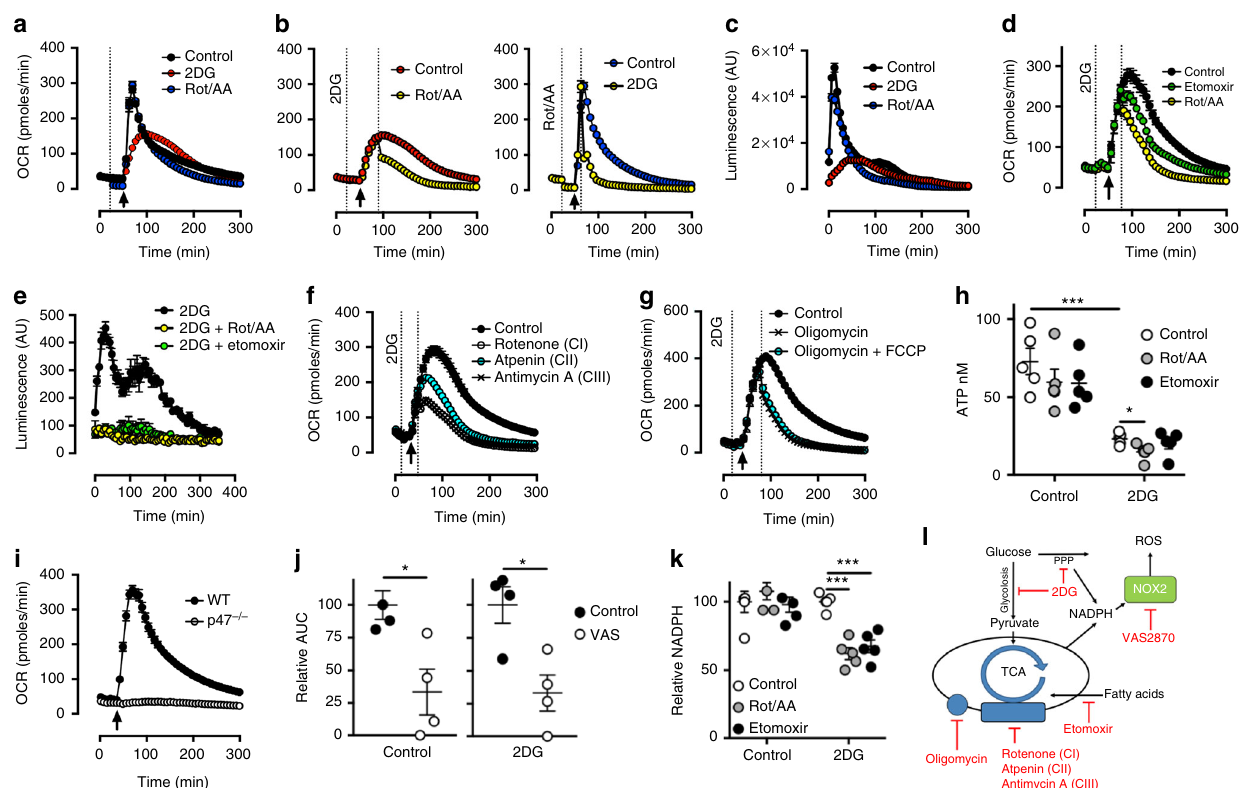
Fig. 2 Neutrophil mitochondria facilitate free radical production. a C57Bl/6J bone marrow neutrophil respiratory burst was measured by oxygen consumption rate (OCR) in response to phorbol 12-myristate 13-acetate (PMA) at the arrow following the addition of indicated compounds at the dotted line. b Following stimulation as described in panel ( a ), neutrophils received a second stimulation of indicated compounds at the second line. Control from panel ( a ). c H 2 O 2 production from bone marrow neutrophils in response to PMA 20 min after the addition of the indicated individual compounds. d OCR in response to the indicated compounds at the second line following the addition of PMA (arrow) and 2DG ( fi rst line). e H 2 O 2 production in response to PMA 20 min after addition of 2DG alone or in combination with the indicated compounds. f OCR values in response to Inhibitors to electron transport chain complexes (CI-III) added at the second line following stimulation with PMA (arrow) and 2DG ( fi rst line). g OCR in response to the complex V inhibitor Oligomycin and Carbonyl cyanide- 4 -(tri fl uoromethoxy)phenylhydrazone (FCCP) were added at the second line, following stimulation with PMA (arrow) and 2DG ( fi rst line). h ATP content of PMA-stimulated bone marrow neutrophils following inhibition with indicated compounds in the presence or absence of 2DG. Data ( n = 5 per group) were analysed by two-way ANOVA with Tukey ’ s multiple comparisons indicated. i OCR in p47 − / − neutrophils in response to PMA (arrow). j Relative total oxygen consumption in response to PMA during NADPH oxidase inhibition by VAS-2870 in the presence or absence of 2DG. Data were analysed by Student's t -test. Control n = 3 pooled from three independent experiments, 2DG n = 4 pooled from two independent experiments. k Relative NADPH levels in PMA-stimulated neutrophils in the presence or absence of 2DG following treatment with indicated compounds. Data ( n = 5) representative of two independent experiments and were analysed by two-way ANOVA with Tukey ’ s multiple comparisons indicated. l Schematic displaying our metabolic model of ROS support, with indicated inhibitors. Concentrations were: Rotenone (Rot, 100 nM), Atpenin (1 µ M), Antimycin A (AA, 1 µ M), 2-DG (100 mM), PMA (1 µ g/ml), FCCP (660 nM), etomoxir (100 µ M), Oligomycin (1.26 µ M), and VAS-2870 (10 μ M). p Values *<0.05, ***<0.001. All error bars denote the mean ±